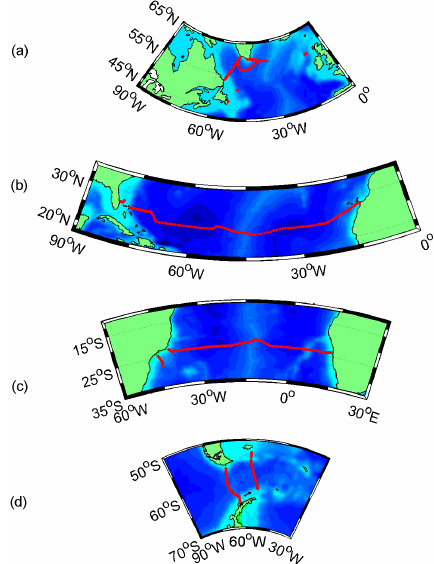
Figure 1. Positions of stations at which DIC and TA samples were taken in the Atlantic and Drake Passage during (a) DI332, (b) DI346, (c) JC032, and (d) JC031 (A21 in the west and SR1b in the